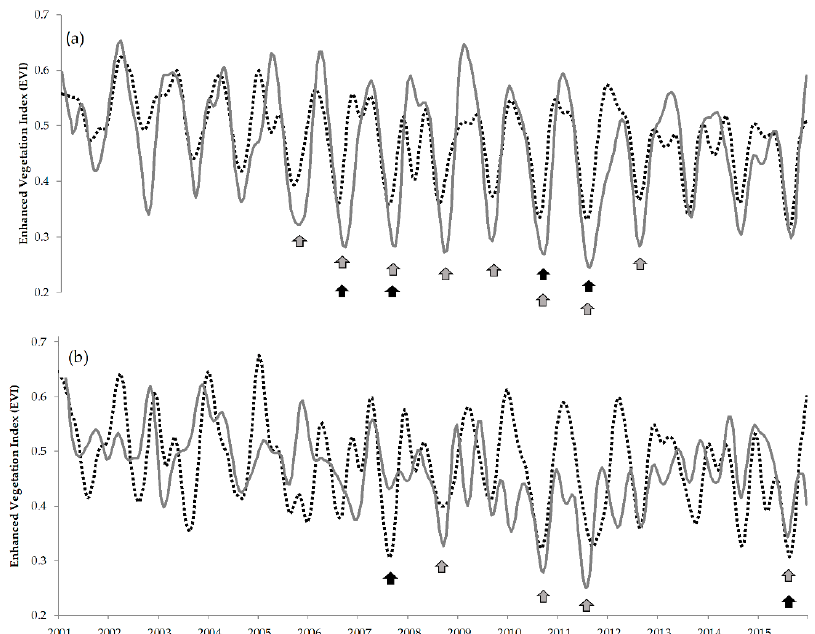
Figure 10. Time series of Enhanced Vegetation Index (EVI) in the Ji-Paraná River Basin, considering: ( a ) pastures, with four (dotted line) and eight (gray line) years of fire; and ( b ) Altered Ombrophilous Forest, with two (dotted line) and four (gray line) years of fire. Arrows indicate the exact dates of fires in these pixels, black arrow for dotted line, and gray arrows for the gray line.